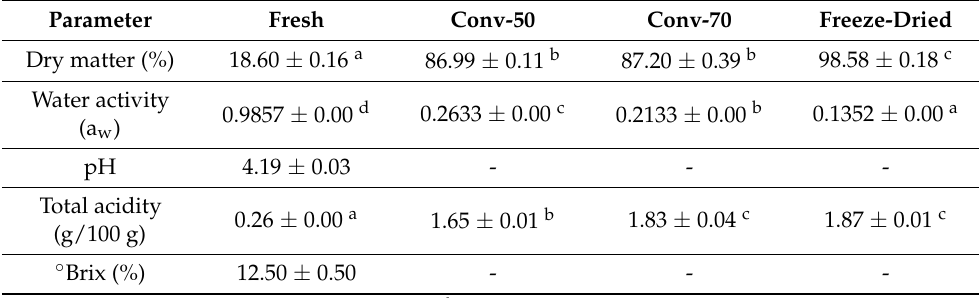
Table 1. Physicochemical properties of fresh and dried